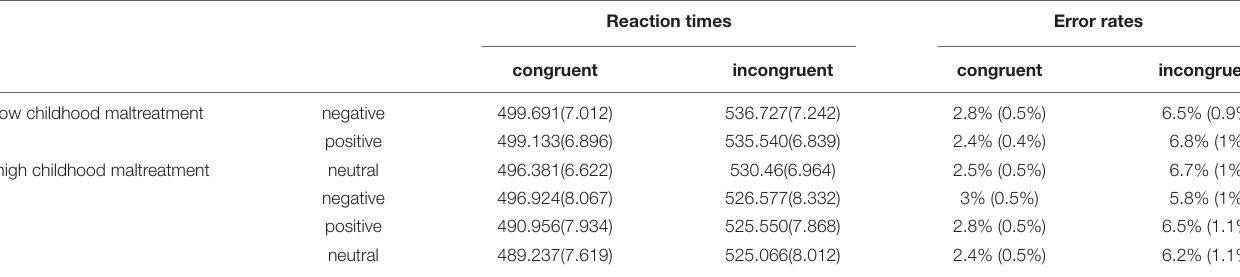
TABLE 1 | During the presentation of negative, neutral and positive pictures, congruent and incongruent conditions elicited average reaction times (in Milliseconds) and error rates for subjects in low and high childhood maltreatment. Reaction times Error rates congruent incongruent congruent